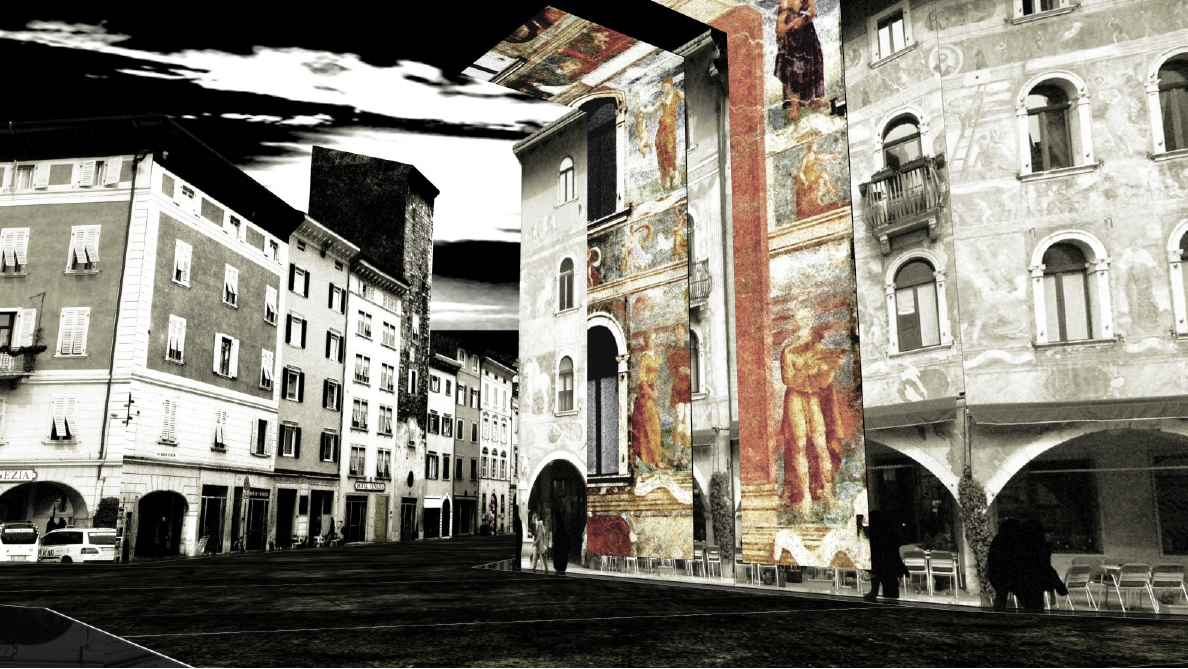
fig. 1 Trento model: the old town centre and a frescoed